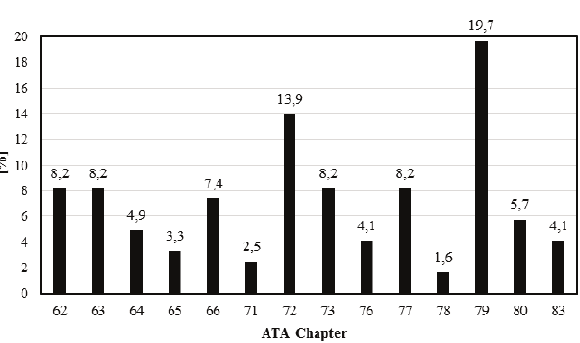
Fig. 21. Share of turboshaft engine system events coded in ATA 100 chapter between 2008 and